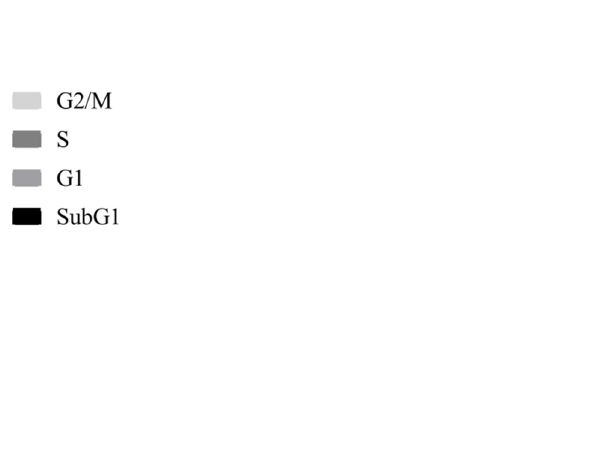
Figure 4. Cell cycle changes in phase distribution of HeLa cells induced by compound after 24 h of treatment.